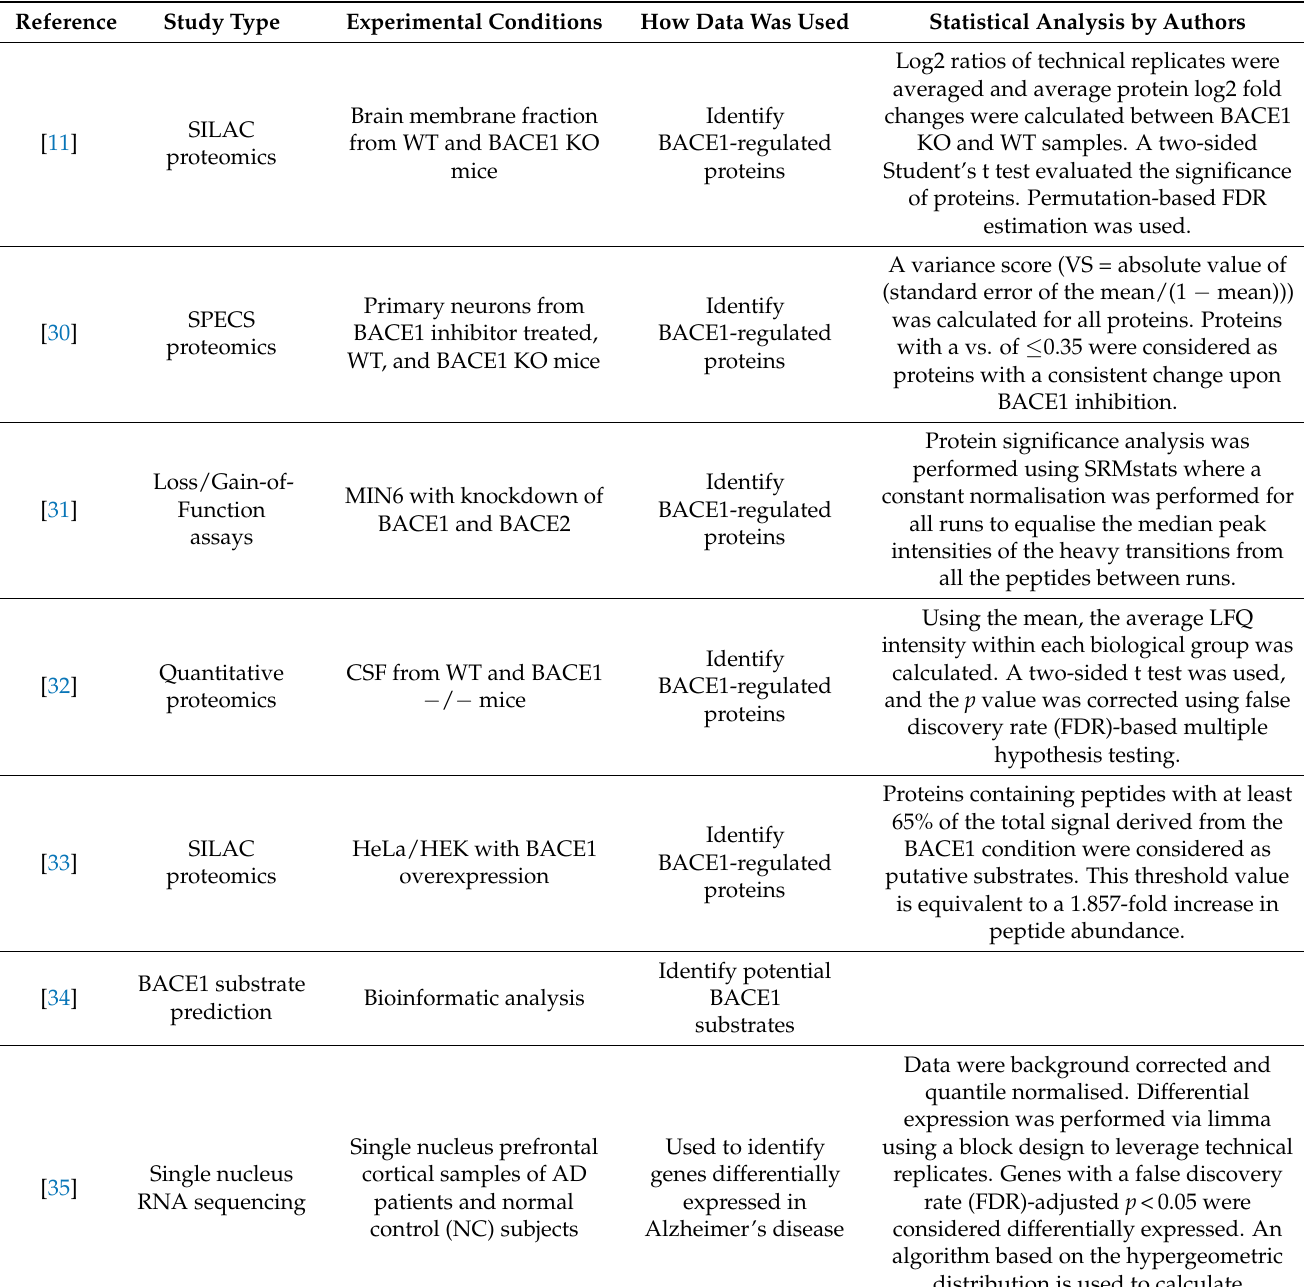
Table 3. Publicly available datasets used for computationally identifying BACE1 substrate